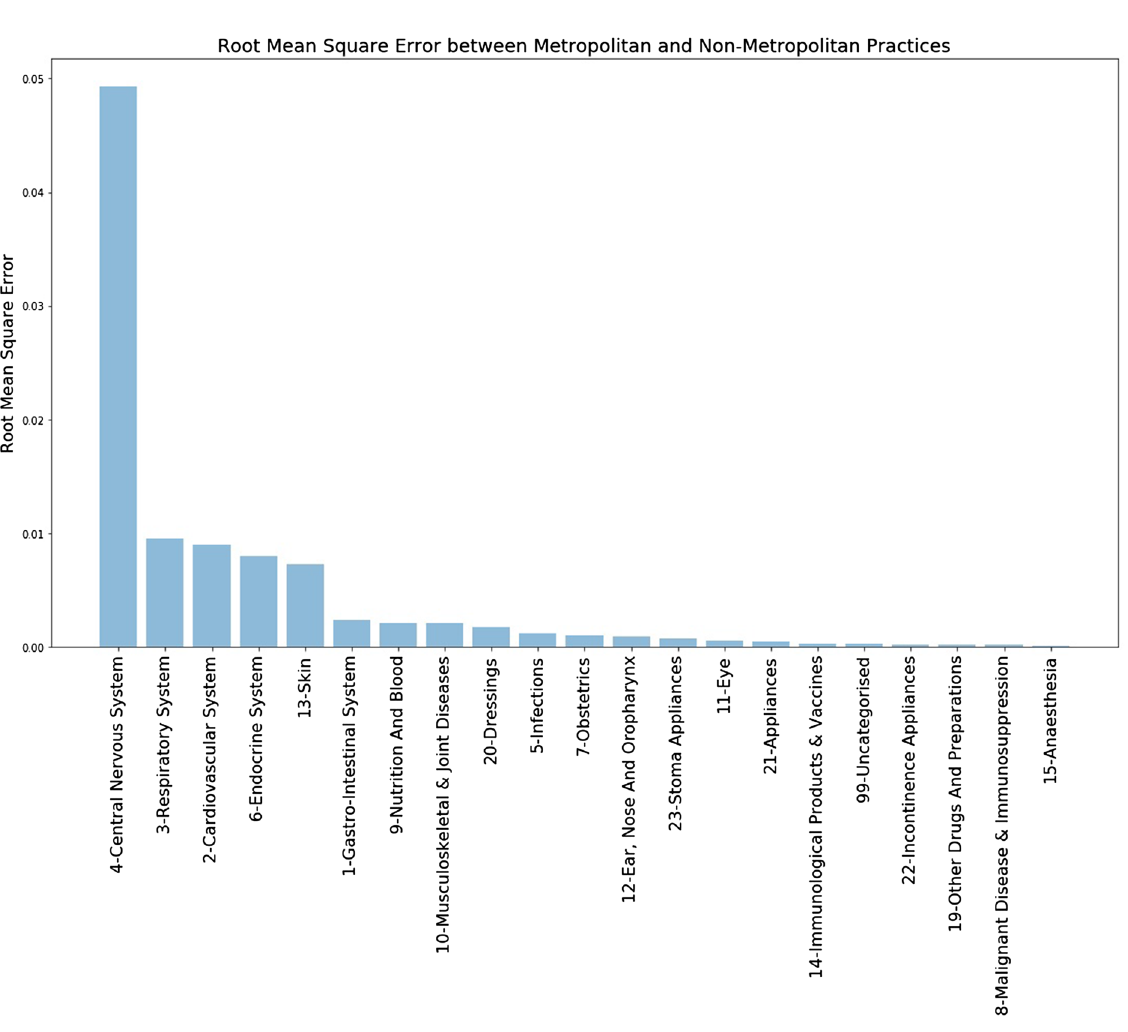
Figure 7. Comparison of RMSE by cluster at BNF chapter